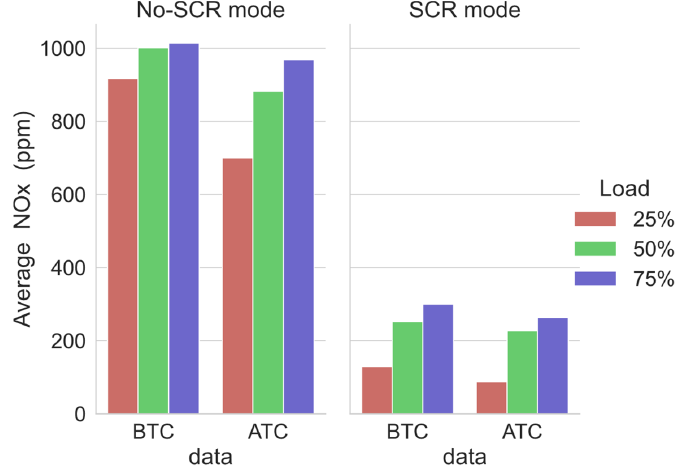
Figure 2. Comparison of NOx ppm levels between no ‐ SCR and SCR modes.